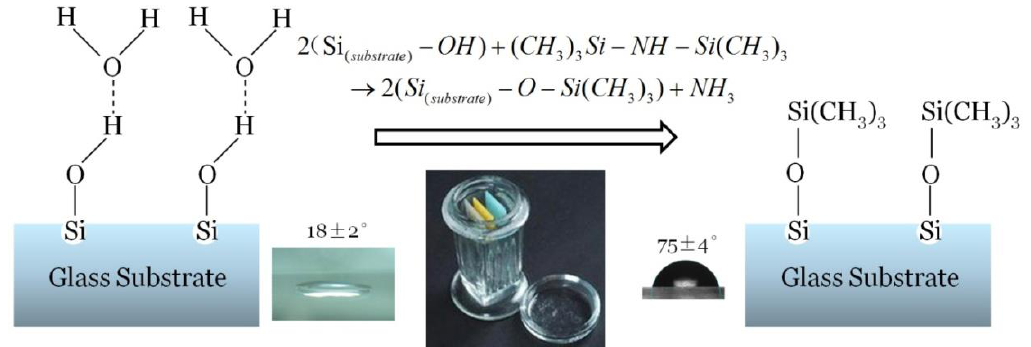
Figure 2. Schematic diagram of hexamethyldisilazane (HMDS) vapor deposition. After HMDS vapor deposition, the contact angle increased to 75° ± 4°, demonstrating strong hydrophobic properties.